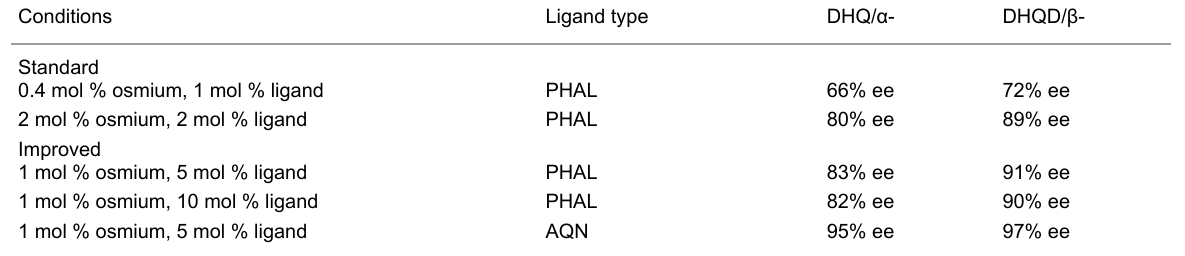
Table 1: Relationship between conditions, ligand and dihydroxylation